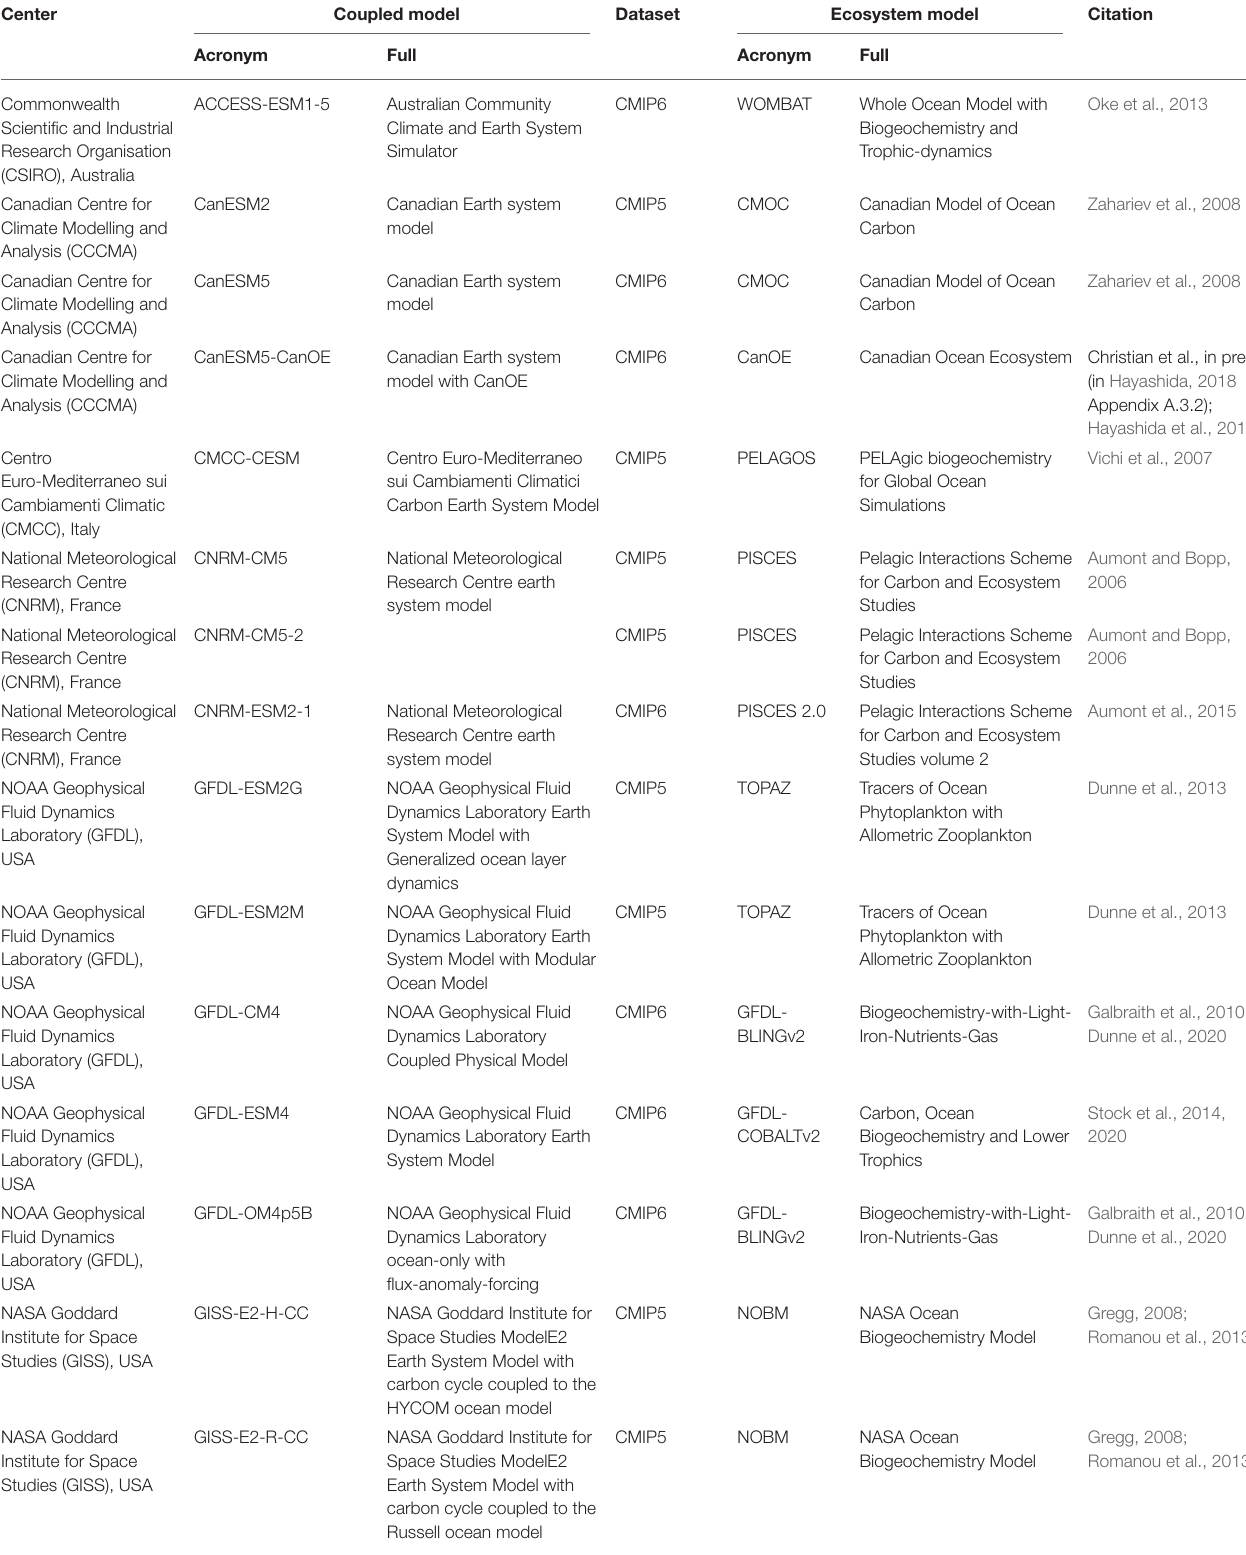
TABLE 2 | A list of global earth system models from the 5th and 6th Coupled Model Intercomparison Projects (CMIP5 and